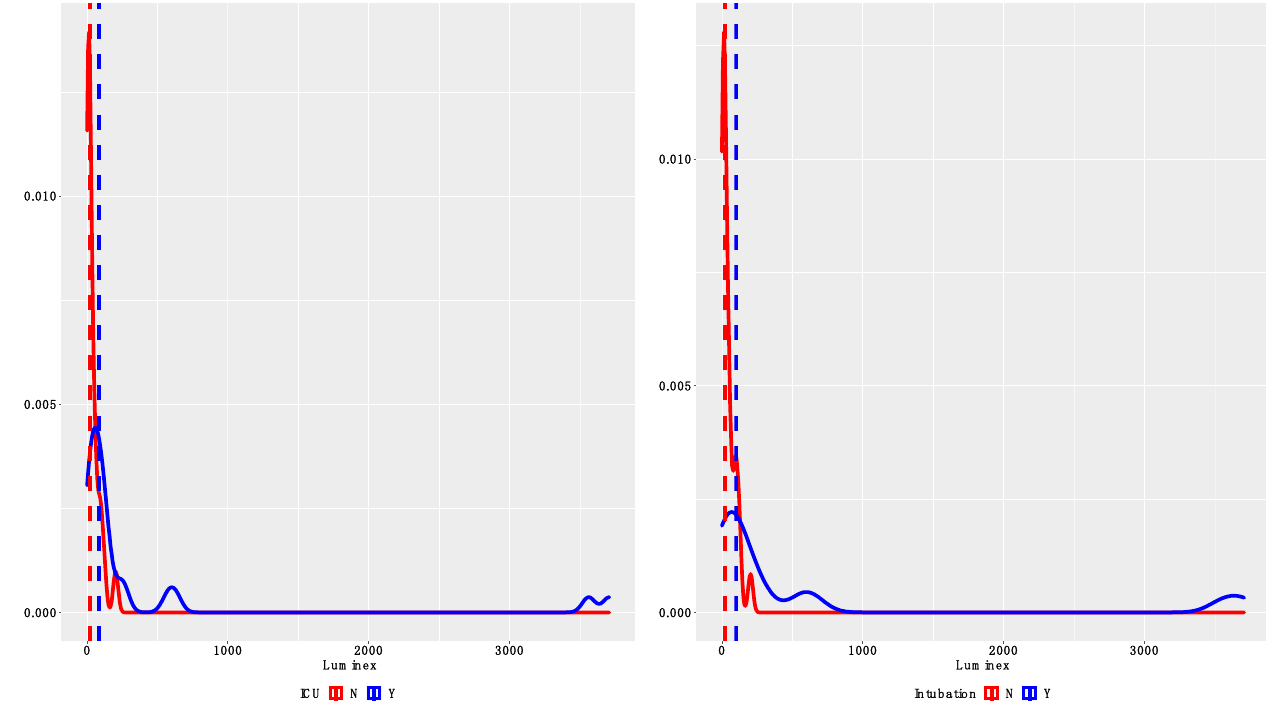
Figure 4. Distribution of QDTI10x, QDTI80x, and Luminex assay by ICU and intubation status. The dashed vertical lines represent median assay values. Y-axis represents density.